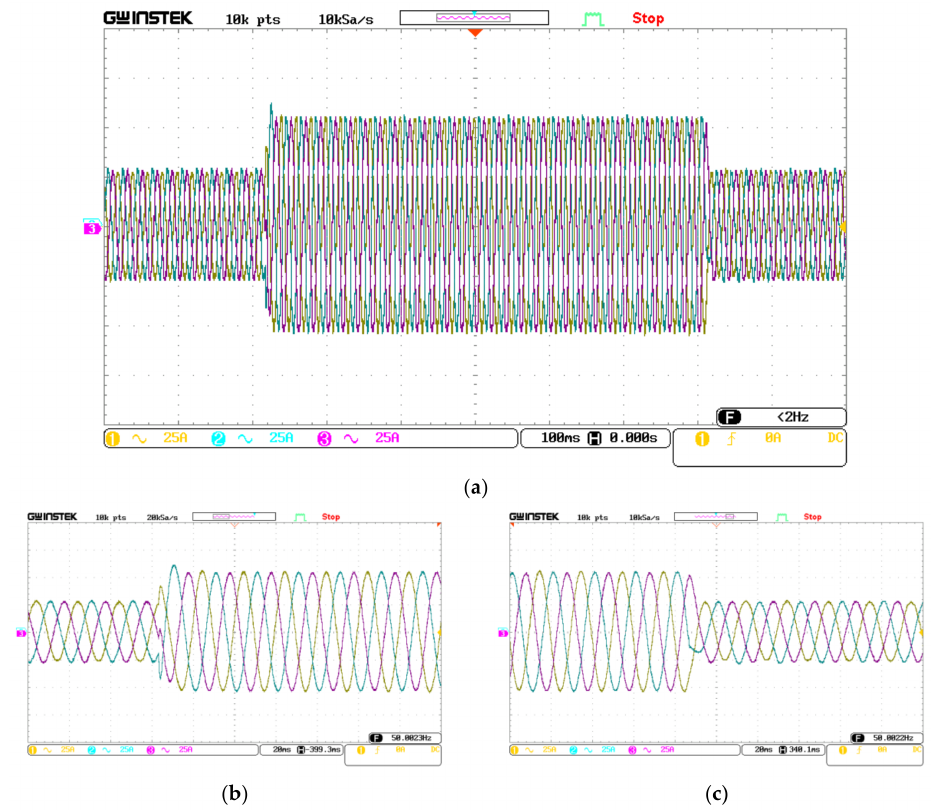
Figure 25. Dynamic experimental waveform of unbalanced load compensation: ( a ) Three-phase grid current after compensation under load fluctuation; ( b ) Local enlargement of grid current with load increasing; ( c ) Local enlargement of grid current with load reducing.